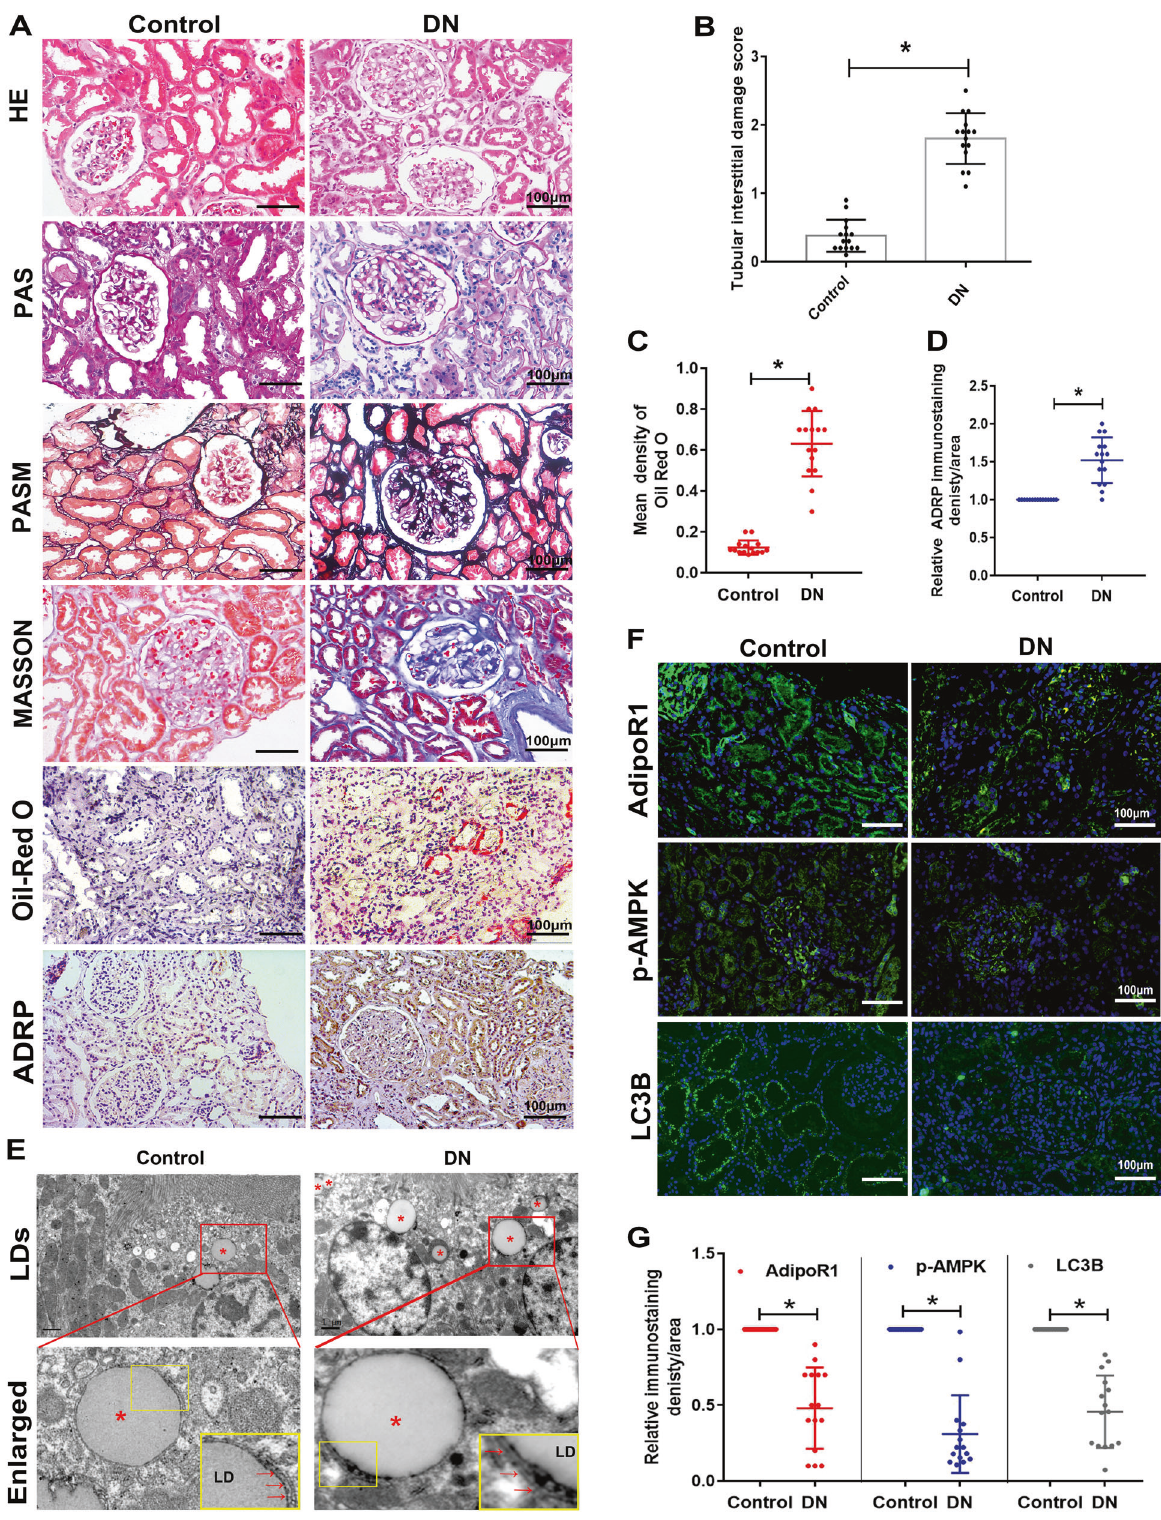
Fig. 1 Decreased lipophagy and pathological changes in the kidney tissues of patients with DN. HE, PAS, PASM, Masson trichrome, Oil-red O staining and immunohistochemical analysis of ADRP in the renal biopsy tissues of patients with DN and control (magni fi cation, ×200) ( A ). Tubular interstitial damage score ( B ). Quanti fi cation of Oil-Red O density ( C ) and ADRP expression ( D ). Ultrastructural analysis of lipid deposition in the kidney tissues of patients with DN and control (magni fi cation, ×10,000) * indicates LDs, red arrows indicate double- membrane autophagic vacuoles containing lipids ( E ). IF analysis and semiquanti fi cation of AdipoR1, p-AMPK and LC3B in the kidney tissues of patients with DN and control individuals ( F , G ). Values are the mean ± SD; * p < 0.05 versus control. n = 15.